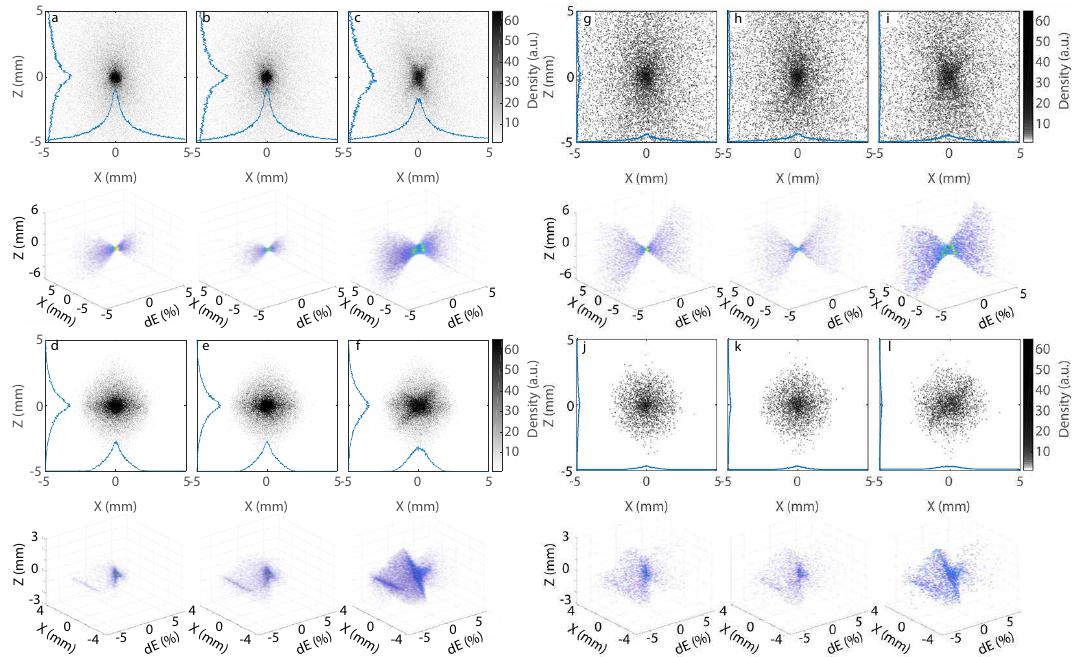
Figure 9. Electron beam transversal shape and vertical–horizontal position per energy at the screens before ( a – c , g – i ) and after ( d – f , j – l ) the undulator for low ( b , e , h , k ), high ( c , f , i , l ), and null ( a , d , g , j ) a 2 terms = 3.12 mrad, and (cid:101) σ (cid:48) x , i , (cid:101) z , i = 0.2 mm.mrad (see Table 1). ( g – l ) High divergence electron beam x , i = 5 mrad, σ (cid:48) = 11.75 mrad, and (cid:101) distribution (Figure 2b) with an initial σ (cid:48) x , i , (cid:101) z , i = 0.2 mm.mrad z , i x , i (see Table 1). Transport with the ”undulator entrance” optics and ”undulator exit”